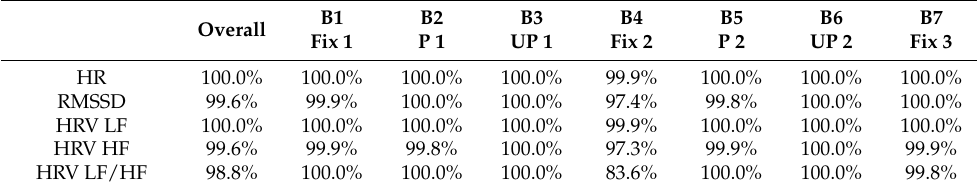
Table 5. ICC in percent for each block and dependent variable.